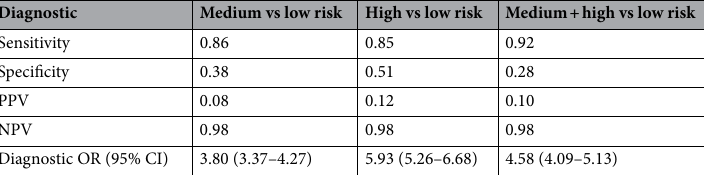
Table 4. Statistical diagnostics of hemorrhage risk-assessment tool for prediction of composite maternal